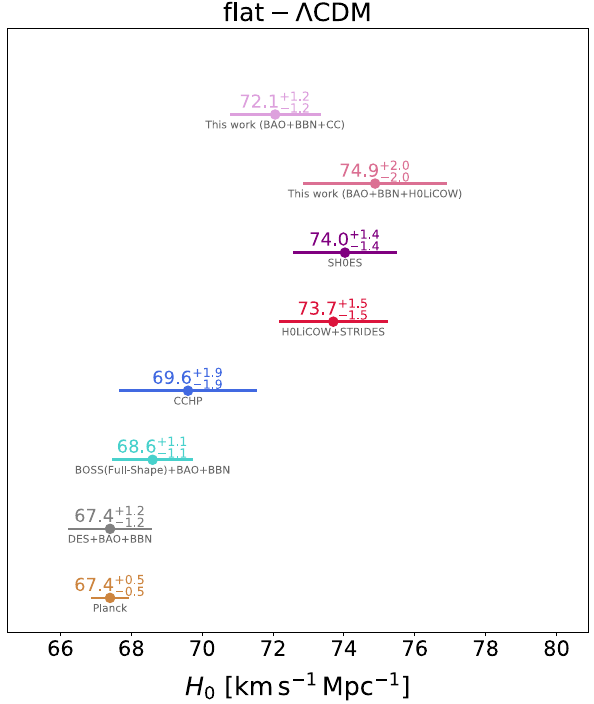
Fig. 2 Compilation of H 0 measurements taken from recent literature, namely, from Planck collaboration (Planck) [1], Dark Energy Sur- vey Year 1 Results (DES+BAO+BBN) [57], the final data release of the BOSS data (BOSS Full-Shape+BAO+BBN) [56], The Carnegie- Chicago Hubble Program (CCHP) [4], H0LiCOW collaboration (H0LiCOW+STRIDES) [3], SH0ES [2], in direct comparison with the H 0 constraints obtained in this work from θ BAO +BBN+H0LiCOW and θ (cid:4) CDM BAO +BBN+CC analyses within the flat-